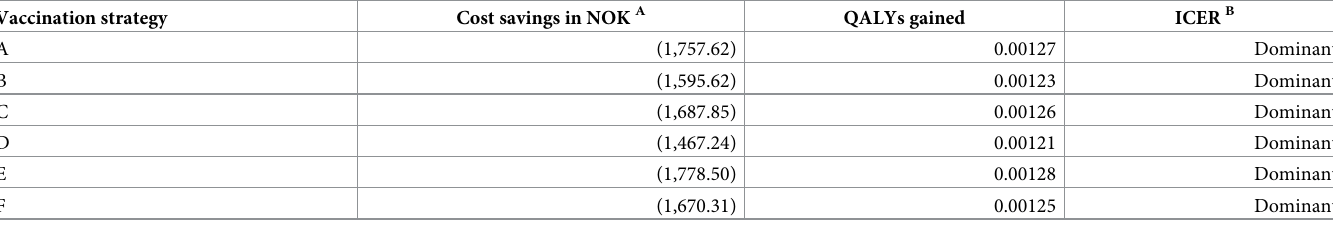
ICER, incremental cost-effectiveness ratio; QALY, quality-adjusted life years A Costs in NOK 2020. The parentheses indicate negative values which represent cost savings.